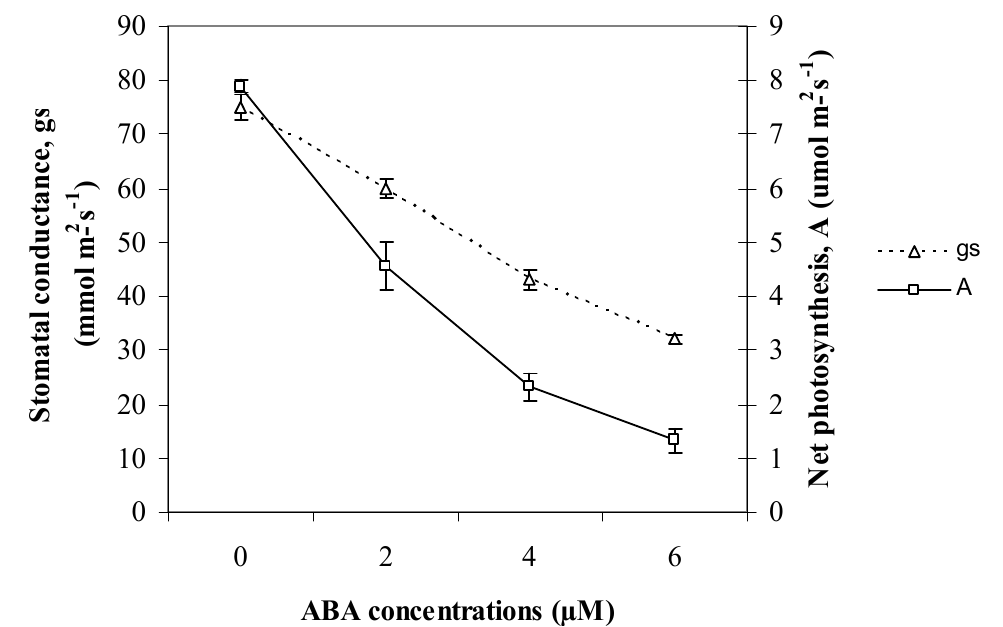
Figure 1. Effect of different ABA levels on leaf gas exchange in leaves of Orthosiphon Stamineus [N = 40; Bars represent standard error of differences between means